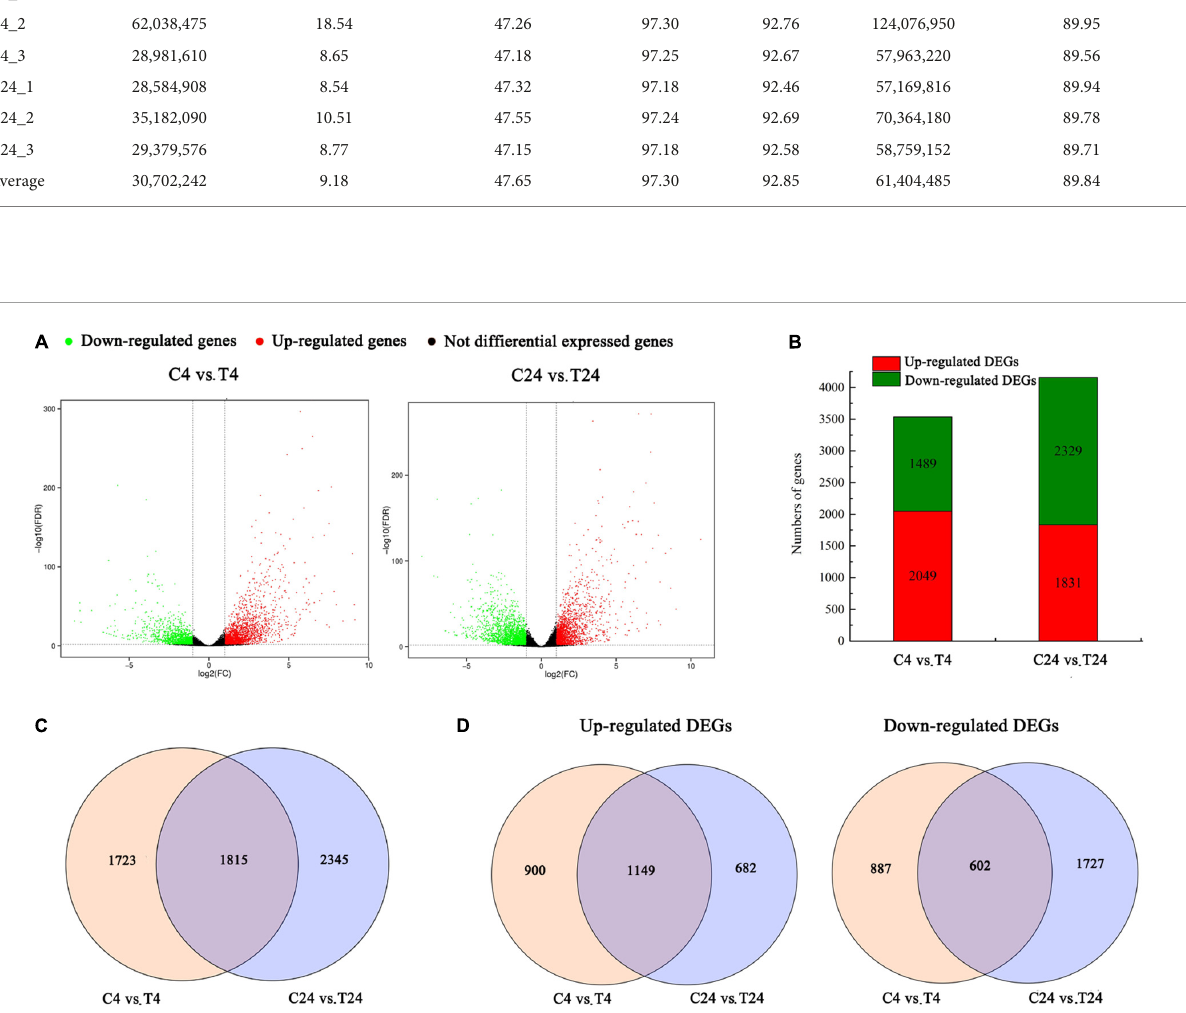
FIGURE3 Differentially expressed genes (DEGs) identified by RNA-Seq analysis in Trp + S + MeJA-treated and control samples after induction for 4 and 24 h. (A) Volcano plot of the RNA-Seq data showing DEGs in red and green. The x -axis indicates the fold change in C4 vs. T4 and C24 vs. T24. The y -axis represents the negative -log 10 -transformed p- values (FDR < 0.01) for differences between the samples. (B) DEG numbers in the C4 vs. T4 and C24 vs. 24 groups. (C) Venn diagram of all DEGs in the C4 vs. T4 and C24 vs. T24 groups. (D) Venn diagram of upregulated and downregulated DEGs in the C4 vs. T4 and C24 vs. T24